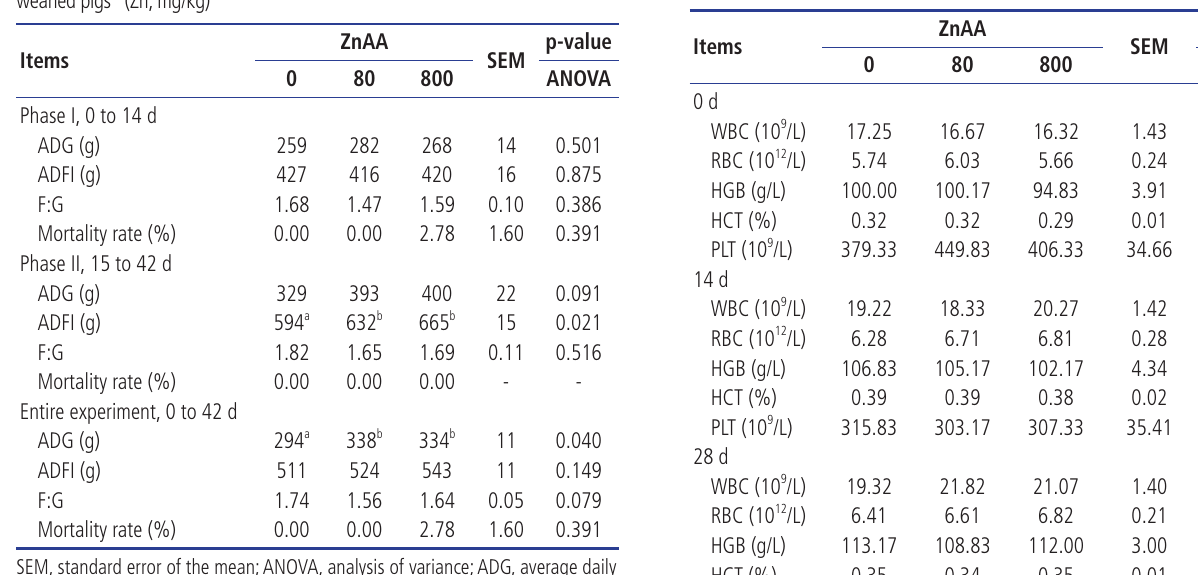
compared to the unsupplemented control (p = 0.05). Hematological parameters : The effects of different dietary supplementation levels of Zn from ZnAA on the hematologi- cal parameters of weaned piglets are presented in Table 6. No significant differences were found in the hematological pa- rameters among the pigs fed 80 or 800 mgZn/kg as ZnAA and the pigs fed the unsupplemented diet (p>0.05).